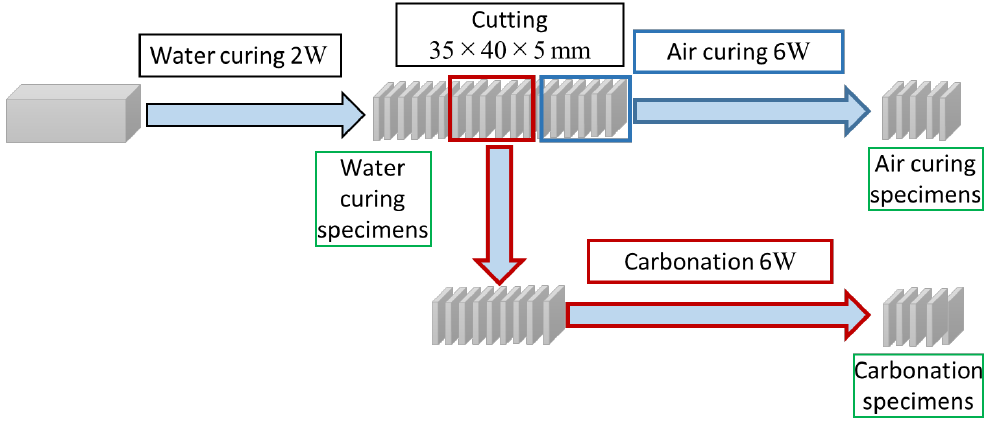
Figure 1. Curing process and sampling process.